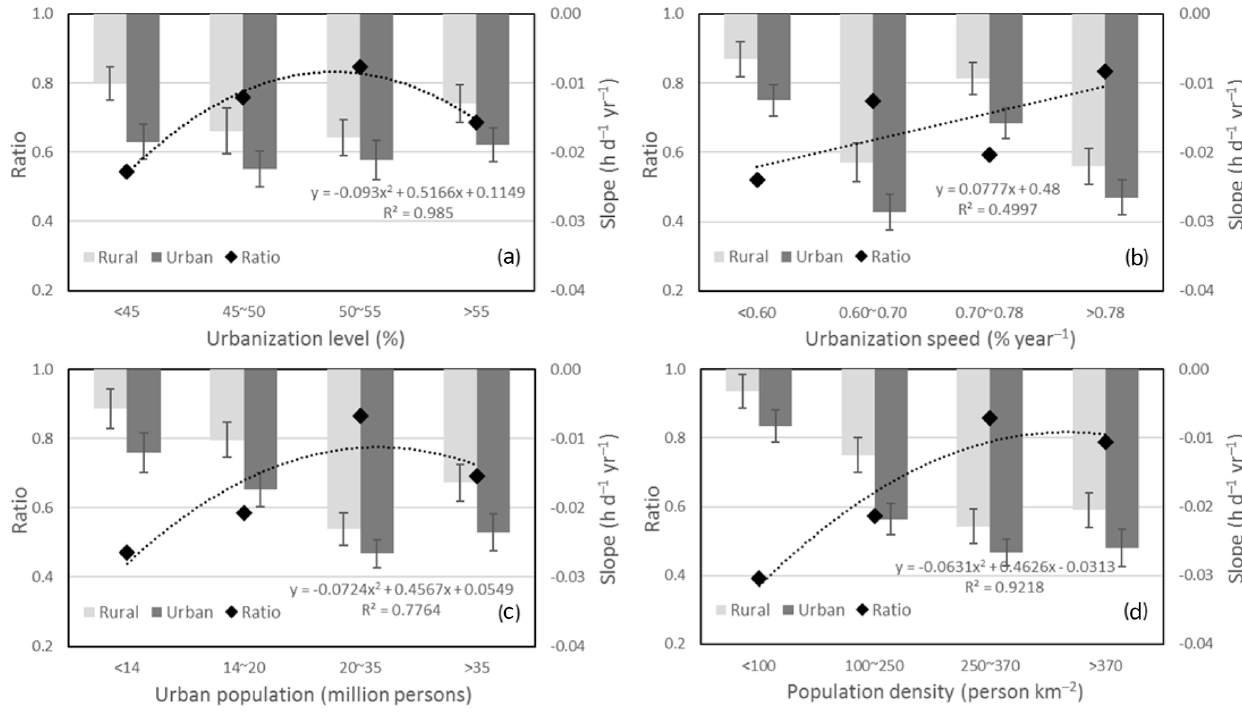
Figure 7. Ratios of the rural to urban trend slopes for sunshine duration (hd − 1 yr − 1 ) in different ranges of urbanization level ( a ; %), urbanization speed ( b ; %yr − 1 ), urban population ( c ; millionpersons), and population density ( d ; personkm − 2 ) in China for the dimming phase of 1960–1989. The cutoff points are chosen based on the quantile